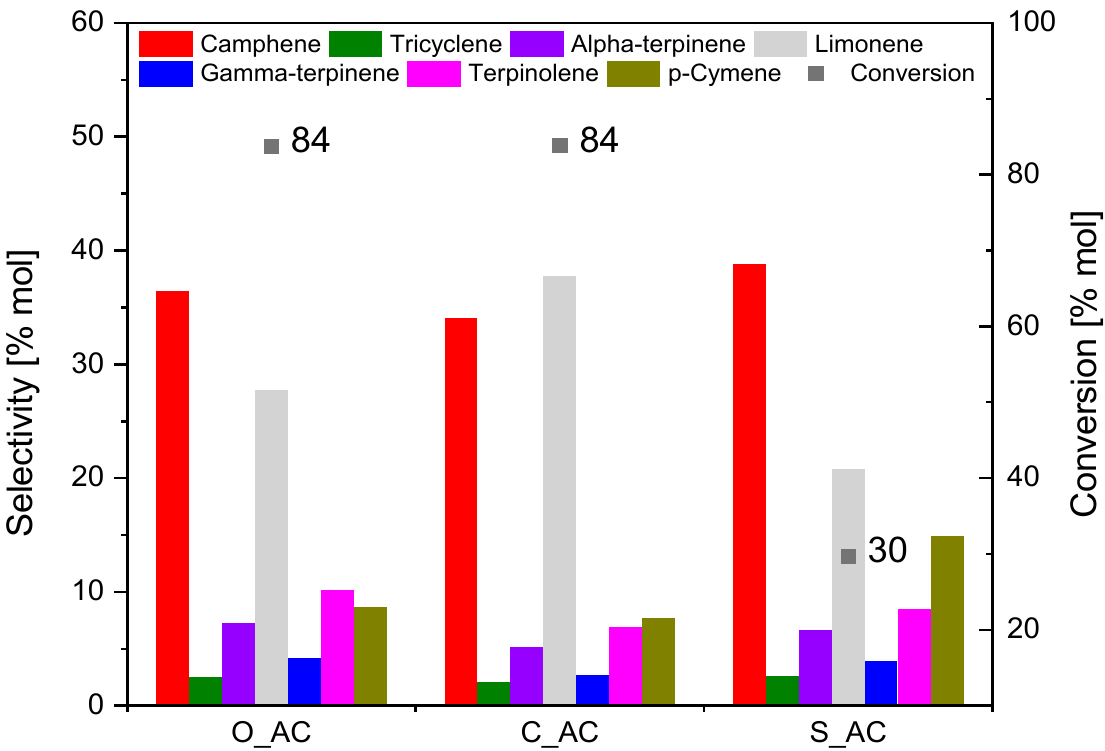
Figure 16. Comparison of the catalytic activity of activated carbons at the most favorable isomerization conditions (content of catalyst 5 wt.%, temperature 160 °C, and reaction time 3 h).